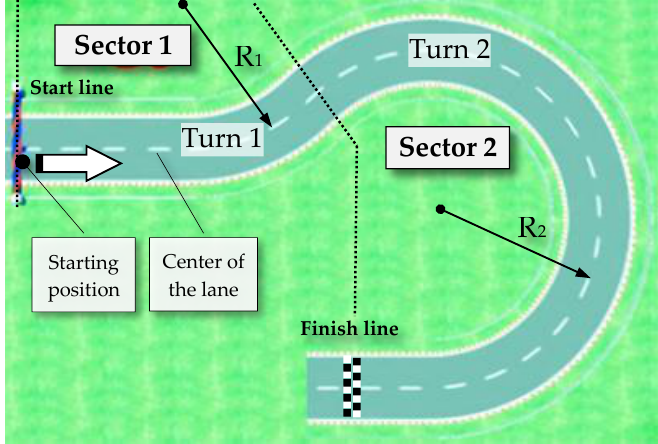
Figure 2. Hook-type test track. Table 2. Main Features of the Test Track.